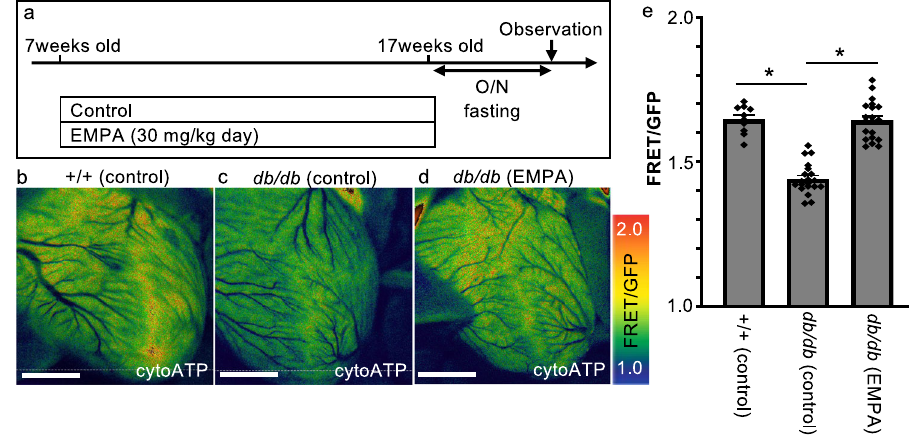
Fig. 1 Chronic treatment with empagli fl ozin reverses cytosolic ATP loss in the heart of T2D model mice. a Schematic illustration of the treatment regimen (EMPA empagli fl ozin). b – d Representative fl uorescence images of a live heart from each condition. Warmer colors indicate higher ATP concentrations. Scale bar: 2 mm. e FRET/GFP ratios indicating the amount of ATP in the heart under each condition ( + / + [control]: n = 10, db / db [control]: n = 20, db / db [EMPA]: n = 20). * p =